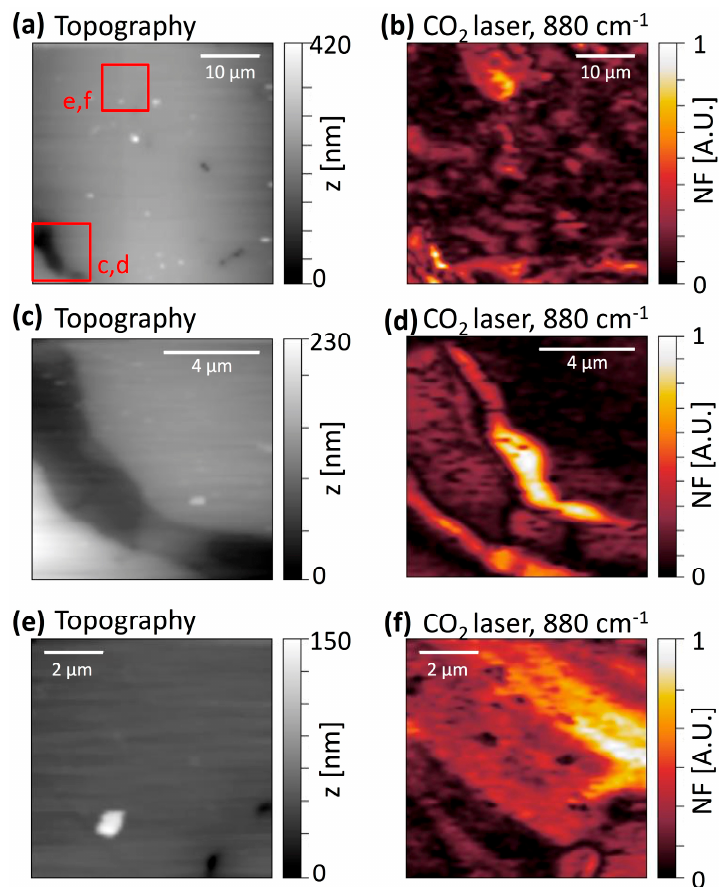
Figure 4. Investigations of KBX reaction products distribution on the 10 − 3 M KBX-treated sample (CCPX-3b) at 880 cm − 1 using the CO 2 laser. ( a ) A 40 μ m × 40 μ m overview topography scan of the examined area. Red squares mark the areas of magnified scans in c,d and e,f, respectively. ( b ) shows the near-field signal on the same area as the overview scan in ( a ). In particular, two areas (bottom left and top middle) show enhanced near-field response. The topography of the 10 μ m × 10 μ m magnified scan with a 3- μ m wide and 100-nm deep curved canyon is depicted in ( c ). ( d ) shows the corresponding near-field response with a strongly enhanced signal at the cliffs of the scan. An 8 μ m × 8 μ m scan of a rather flat area can be found in ( e ). Here, an enhanced near-field signal ( f ) is found in an area with a size of roughly 8 μ m × 2 μ m.